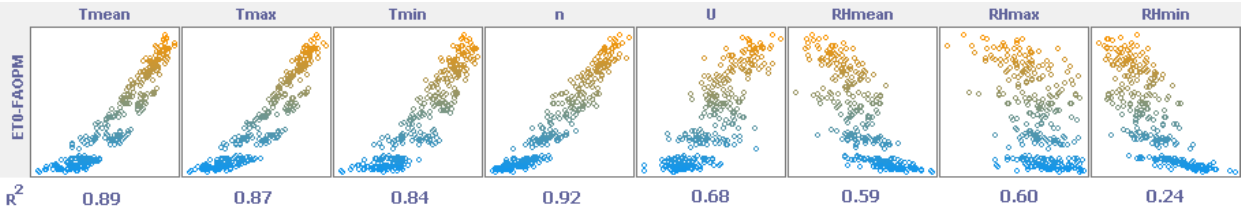
Figure 3. Scatter plot showing the correlation between ET 0 and the independent variable. The coefficient of determination has been added for clarity.